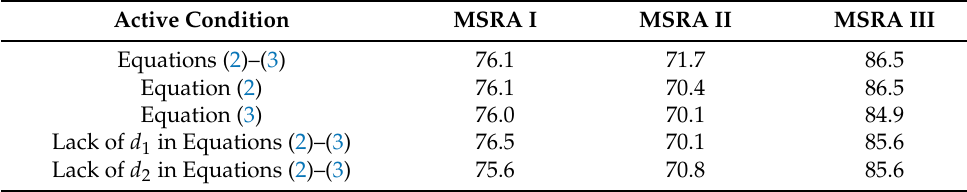
Figure 7. The 2D MDS embeddings of DTW dissimilarities between sequences of reduced dimen- sionality from the MSRA I dataset for CGAN and ARSPAWNER. Colors are used to differentiate the classes, the filled triangles denote input examples ( a , c ), while filled circles denote augmented samples ( b , d ). Table 7. Performance of ARSPAWNER with active